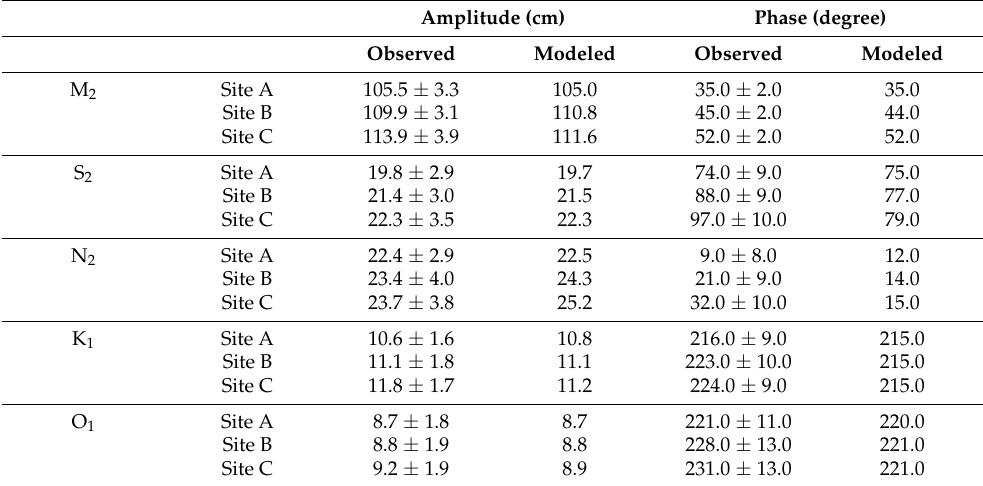
Table 1. Observed and model-computed tidal amplitudes and phases of M 2 , S 2 , N 2 , K 1 , and O 1 tidal elevations at sites A, B and C (the measurements were made from 28 February to 26 April 2001).